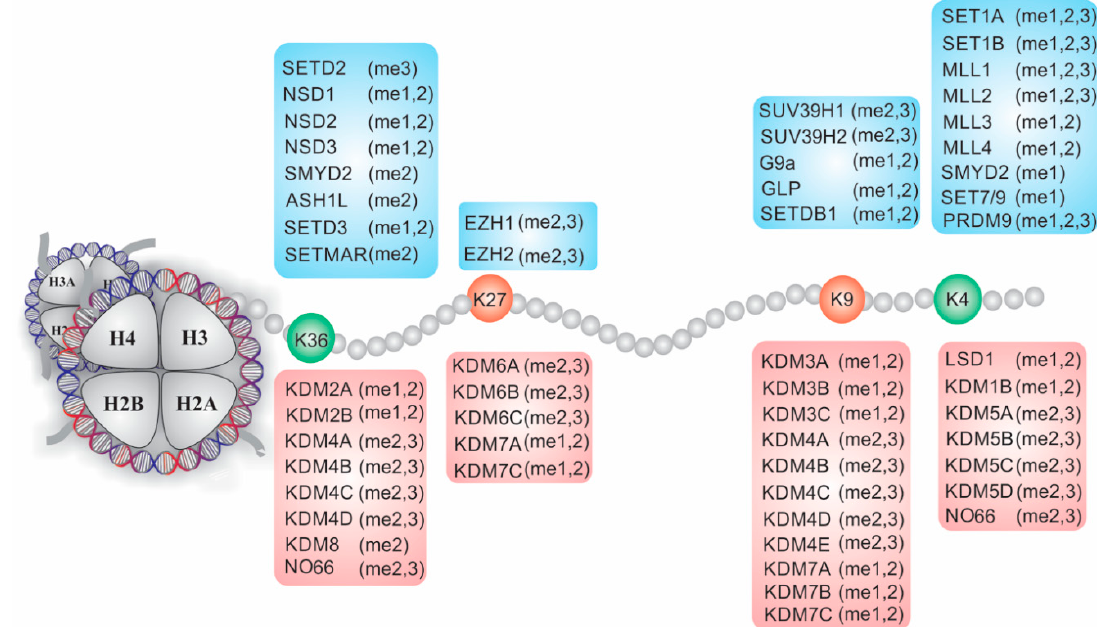
Figure 2. Nucleosome structure and dynamic modulation of lysine methylation on histone H3 mediated by histone lysine methyltransferases and demethylases (KDMs).